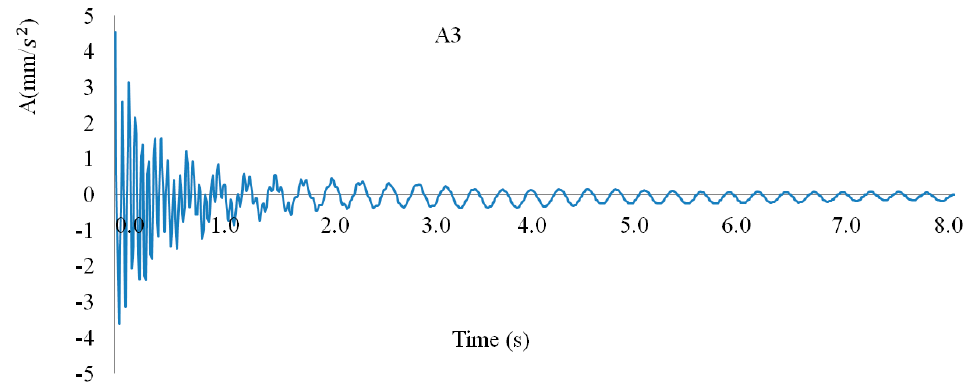
Figure 15. Acceleration time-history curve.